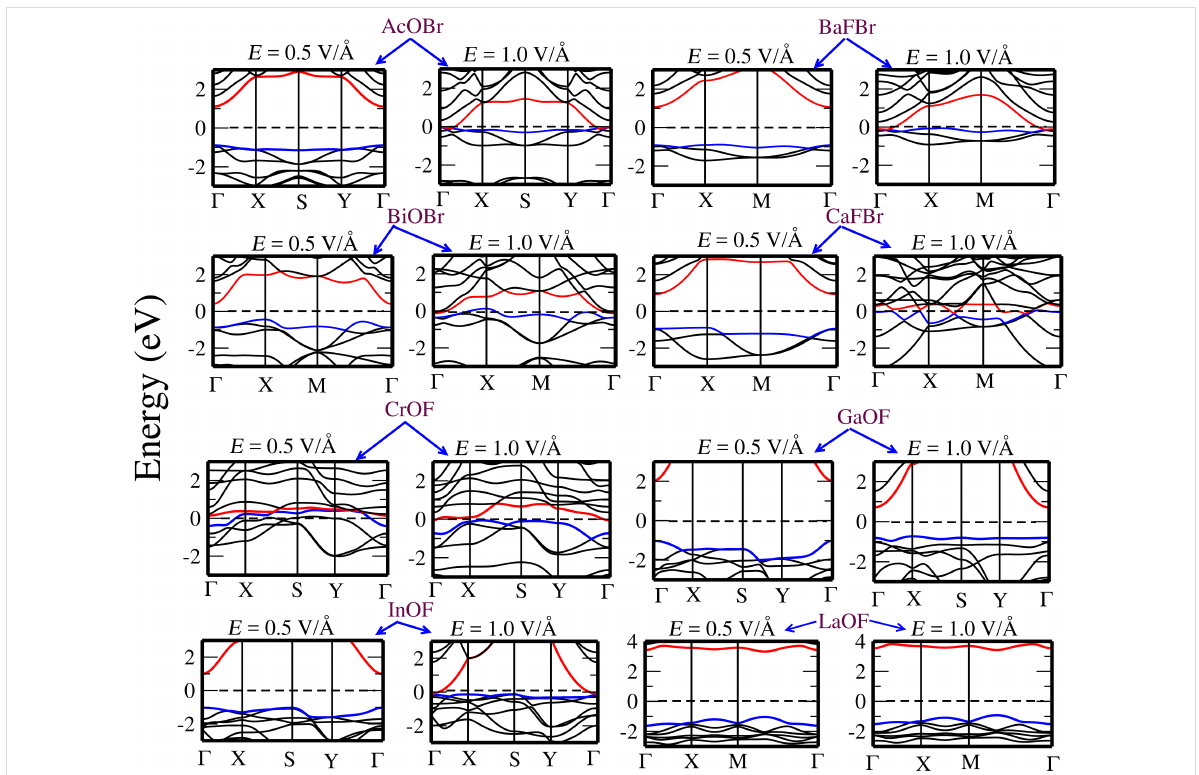
Figure 11: Evolution of the electronic band structure of AcOBr, BaFBr, BiOBr, CaFBr, CrOF, GaOF, InOF, and LaOF single layers as a function of applied electric field. Calculations are performed with PBE. The top of the valence band (red) and bottom of conduction band (blue) are indicated. The Fermi level is set to 0